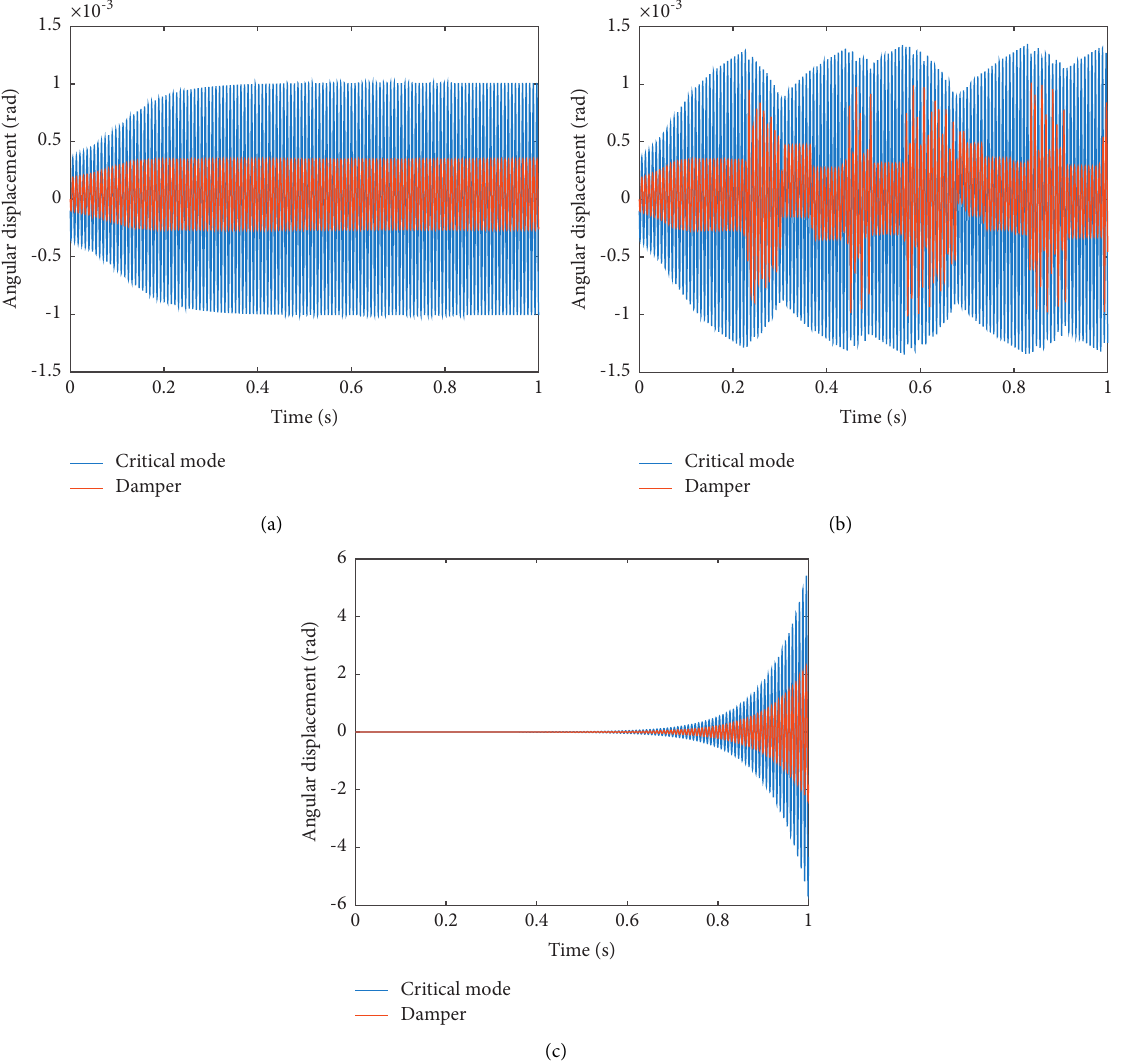
Figure 16: Time domain results from the self-excited minimal model for (a) D